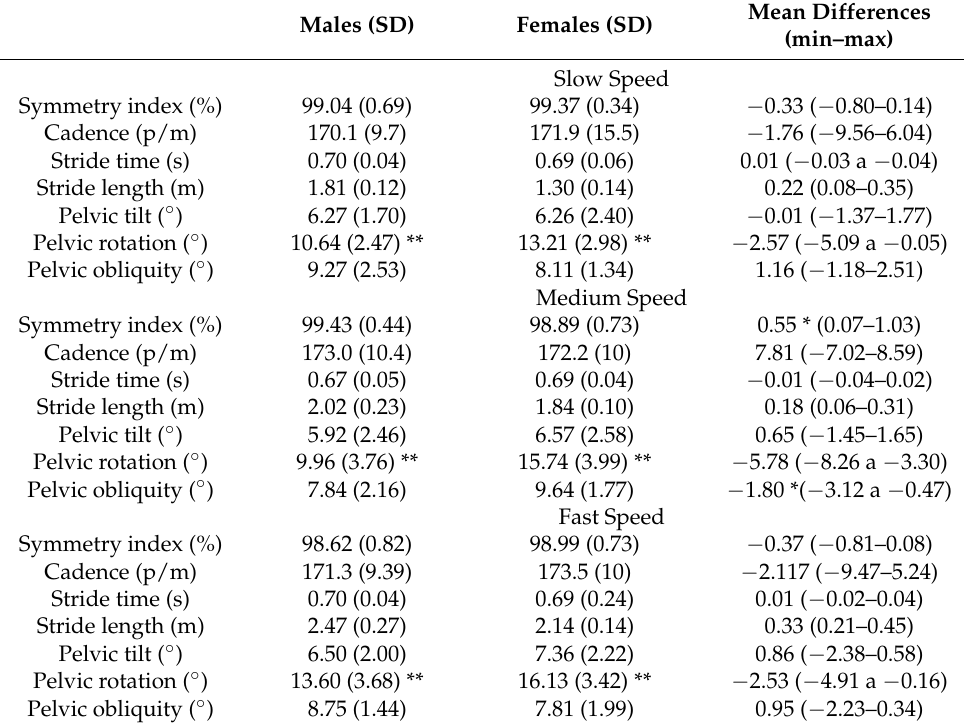
Figure 2. Pelvic tilt trace with mean amplitude in males and females. Negative degrees represent a retroversion of the pelvis. Positive degrees represent anteversion of the pelvis. No statistical differences found in remaining speed levels or between sexes. Table 2. Spatiotemporal outcomes according to sex and speed levels.